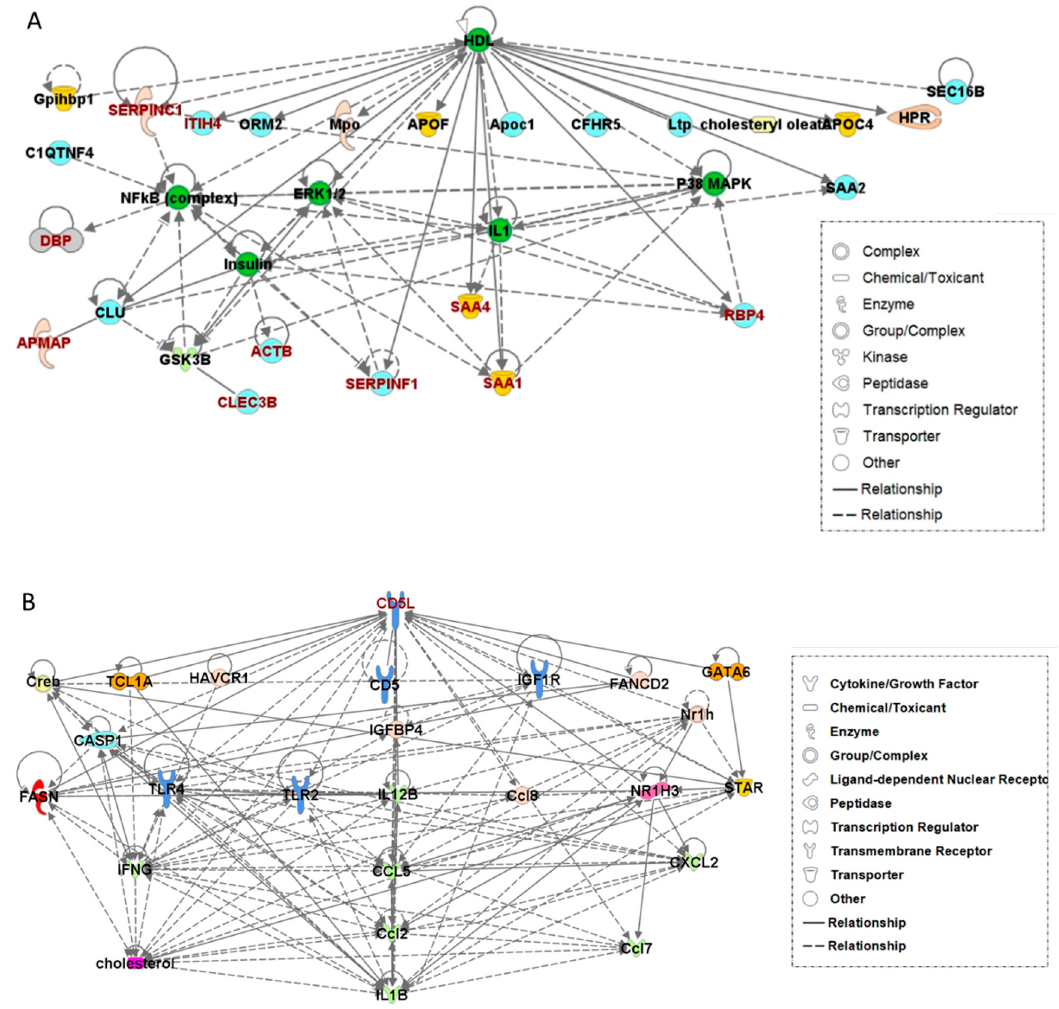
Figure 4. Network analysis performed using ingenuity pathway analysis (IPA). ( A ) Network 1 including nine of the previously identified differentially expressed proteins. ( B ) Network 2 with CD5L as the hub protein.